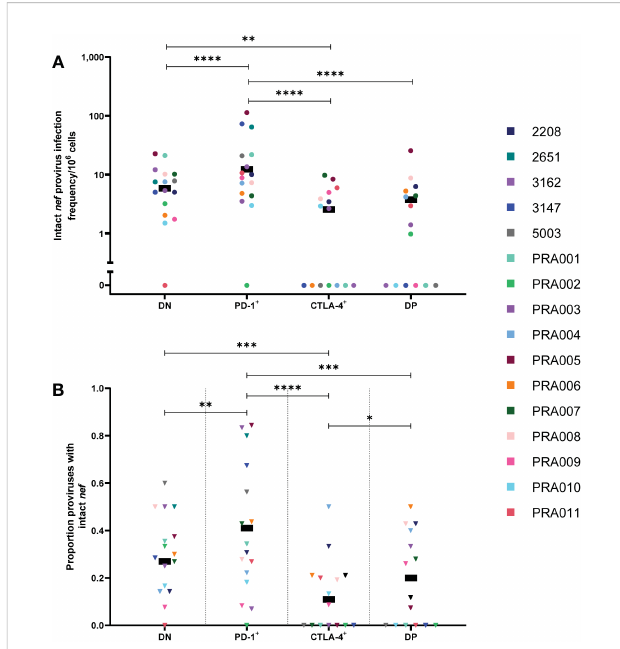
FIGURE 3 HIV-1 proviruses with an intact nef open reading frame in peripheral blood memory CD4 + T-cells expressing PD-1 and/or CTLA-4. The HIV-1 infection frequency per 10 6 cells of proviruses with an intact nef ORF in DN, PD-1 + , CTLA-4 + and DP cells (A) . The proportion of ampli fi ed proviruses that contained an intact nef ORF in DN, PD-1 + , CTLA-4 + and DP cells (B) . Data is the estimated infection frequency per 10 6 cells or proportion for each subset. p-values represent evidence for an overall trend of a difference between subsets within these participants (mixed effects logistic regression), * p ≤ 0.05, ** p ≤ 0.01, *** p ≤ 0.001, **** p ≤